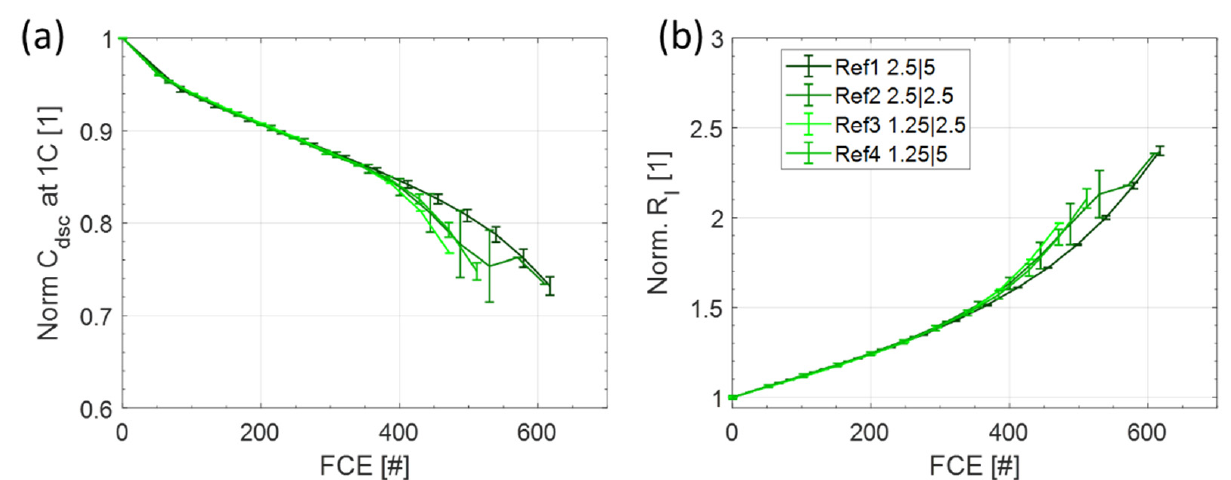
Figure 4. Relative discharge capacity ( a ) and relative pulse resistance ( b ) of the reference cells at different charge and discharge currents as a function of the full cycle equivalents.